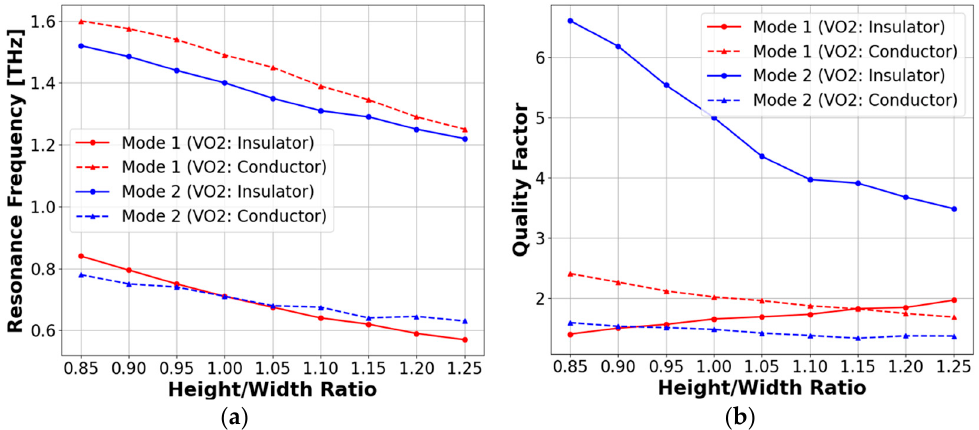
Figure 5. ( a ) Resonant frequency and ( b ) quality factor of the double-split rectangular metamaterial in modes 1 and 2 with the VO 2 thin film in the insulator and conductor states according to the aspect ratio of the rectangle.